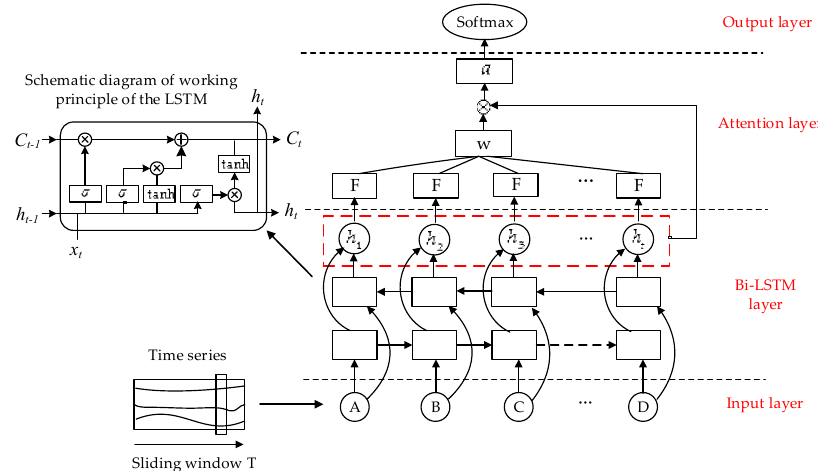
Figure2. Figure 2. Bidirectional long short-term memory network (Bi-LSTM) model with an attention mechanism.